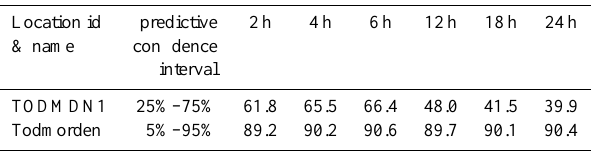
Table 1. Percentage of observations within respective predictive confidence intervals for period January 2008–July 2009 for forecast location Todmorden (North East Region).